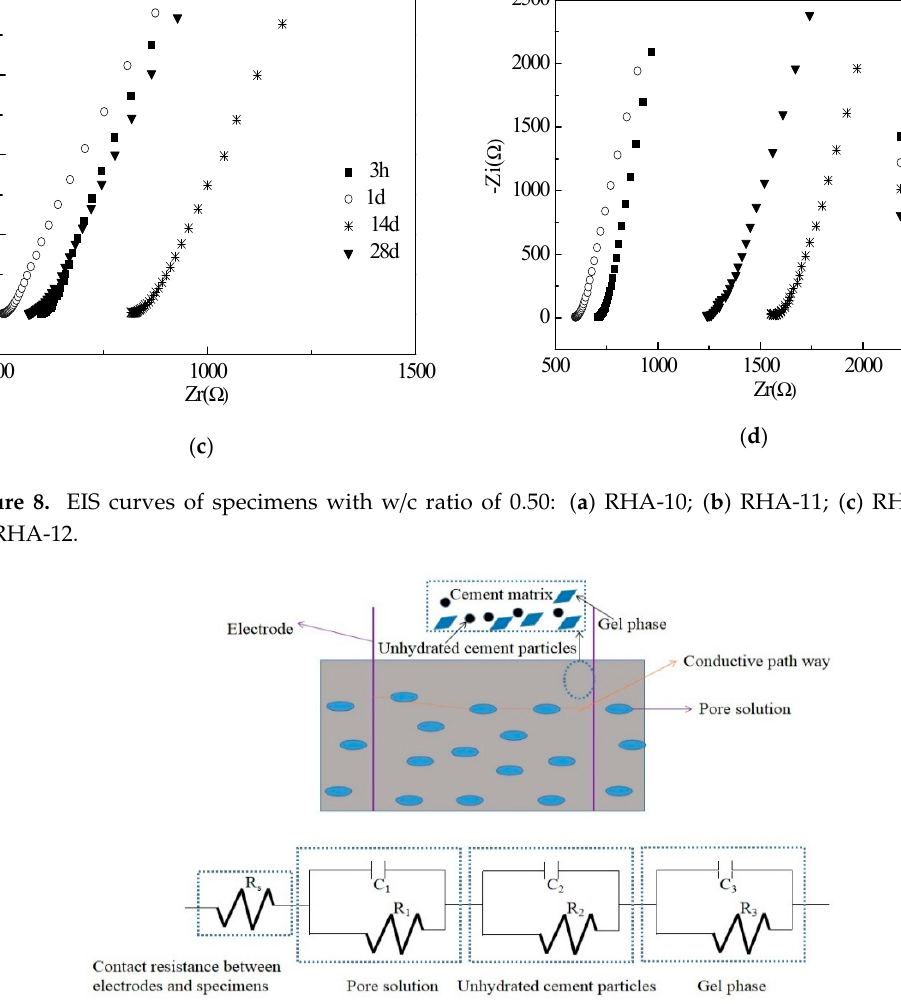
Figure 9. Corresponding equivalent circuits of specimens with RHA.